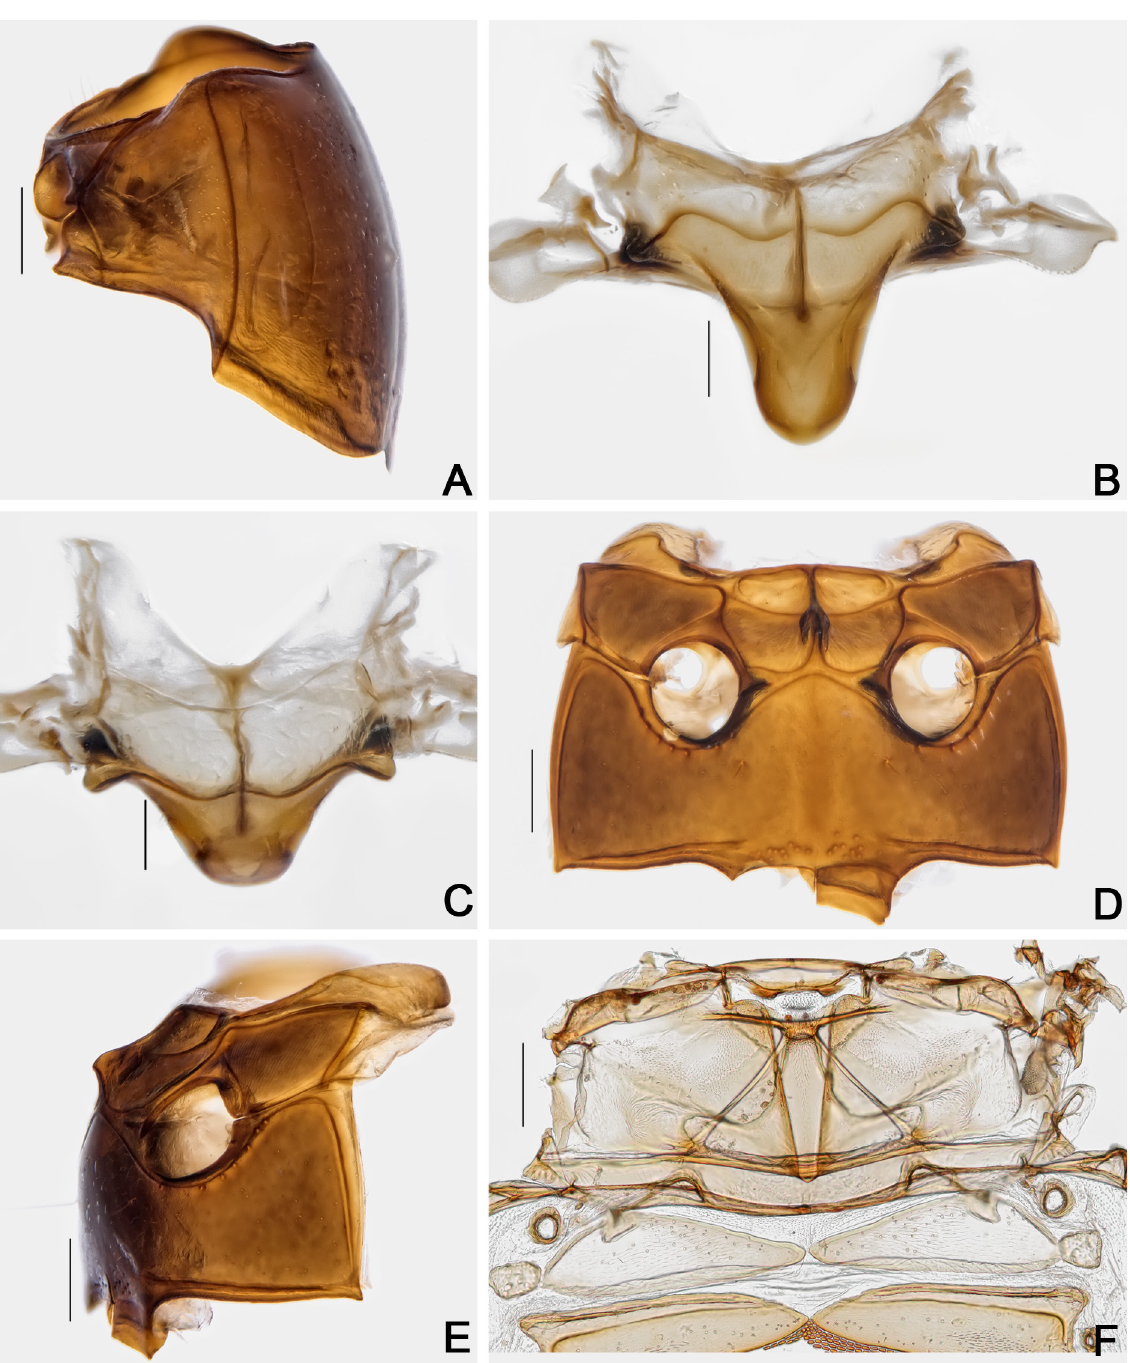
Fig. 25. Cyparium loebli sp. nov., paratype, ♂ (CELC). A . Prothorax, lateral view. B–C . Scutellar plate. B . Dorsal view. C . Apically slanted view. D–E . Meso- and metathorax. D . Ventral view. E . Lateral view. F . Metanotum. Specimen collected at Mata do Paraíso, Viçosa (MG, Brazil). Scale bars: A, D–F = 0.2 mm; B–C = 0.1